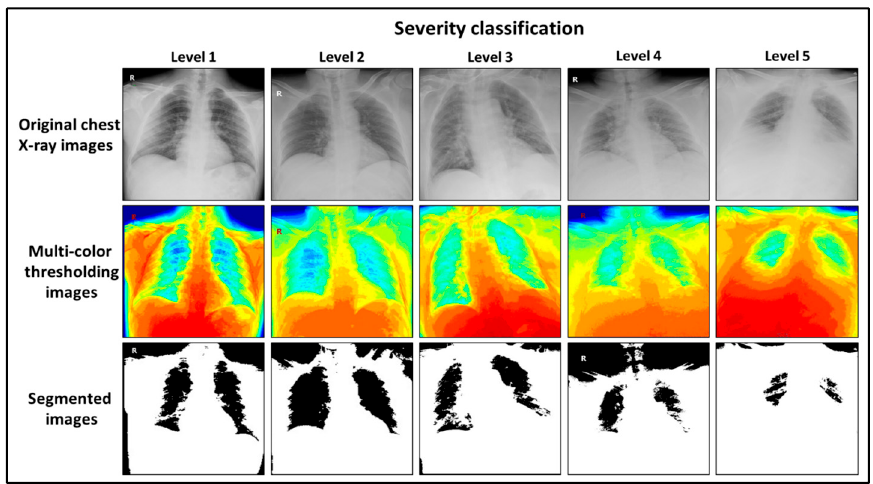
Figure 2. Chest X-ray images for five confirmed SARS-COV2 cases. These images show the levels of severity of inflammation in three different modes: original image mode (first row), multi-color thresholding mode (second row), and segmentation mode (third row).